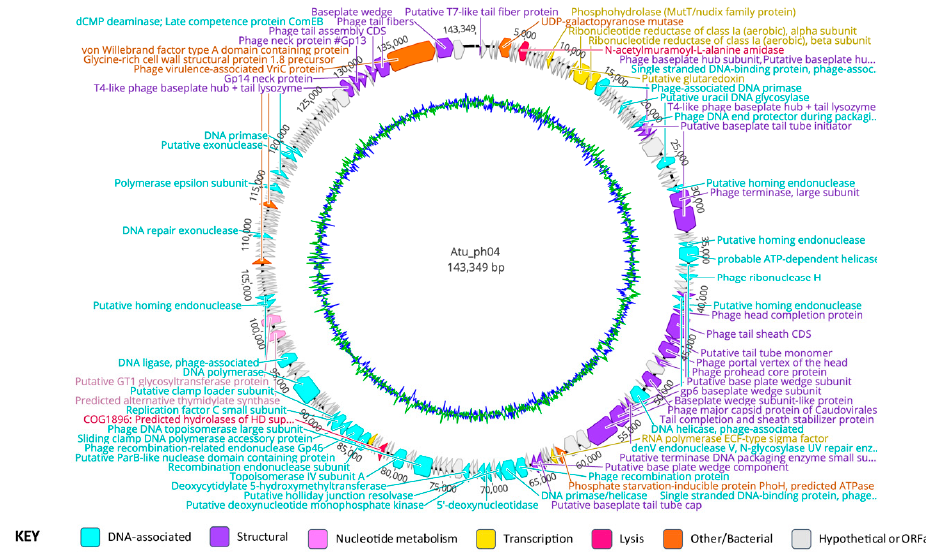
Figure 2. Genome annotation of Atu_ph04, color-coded by functional annotation. G + C content represented by inner circle: AT = green; GC =